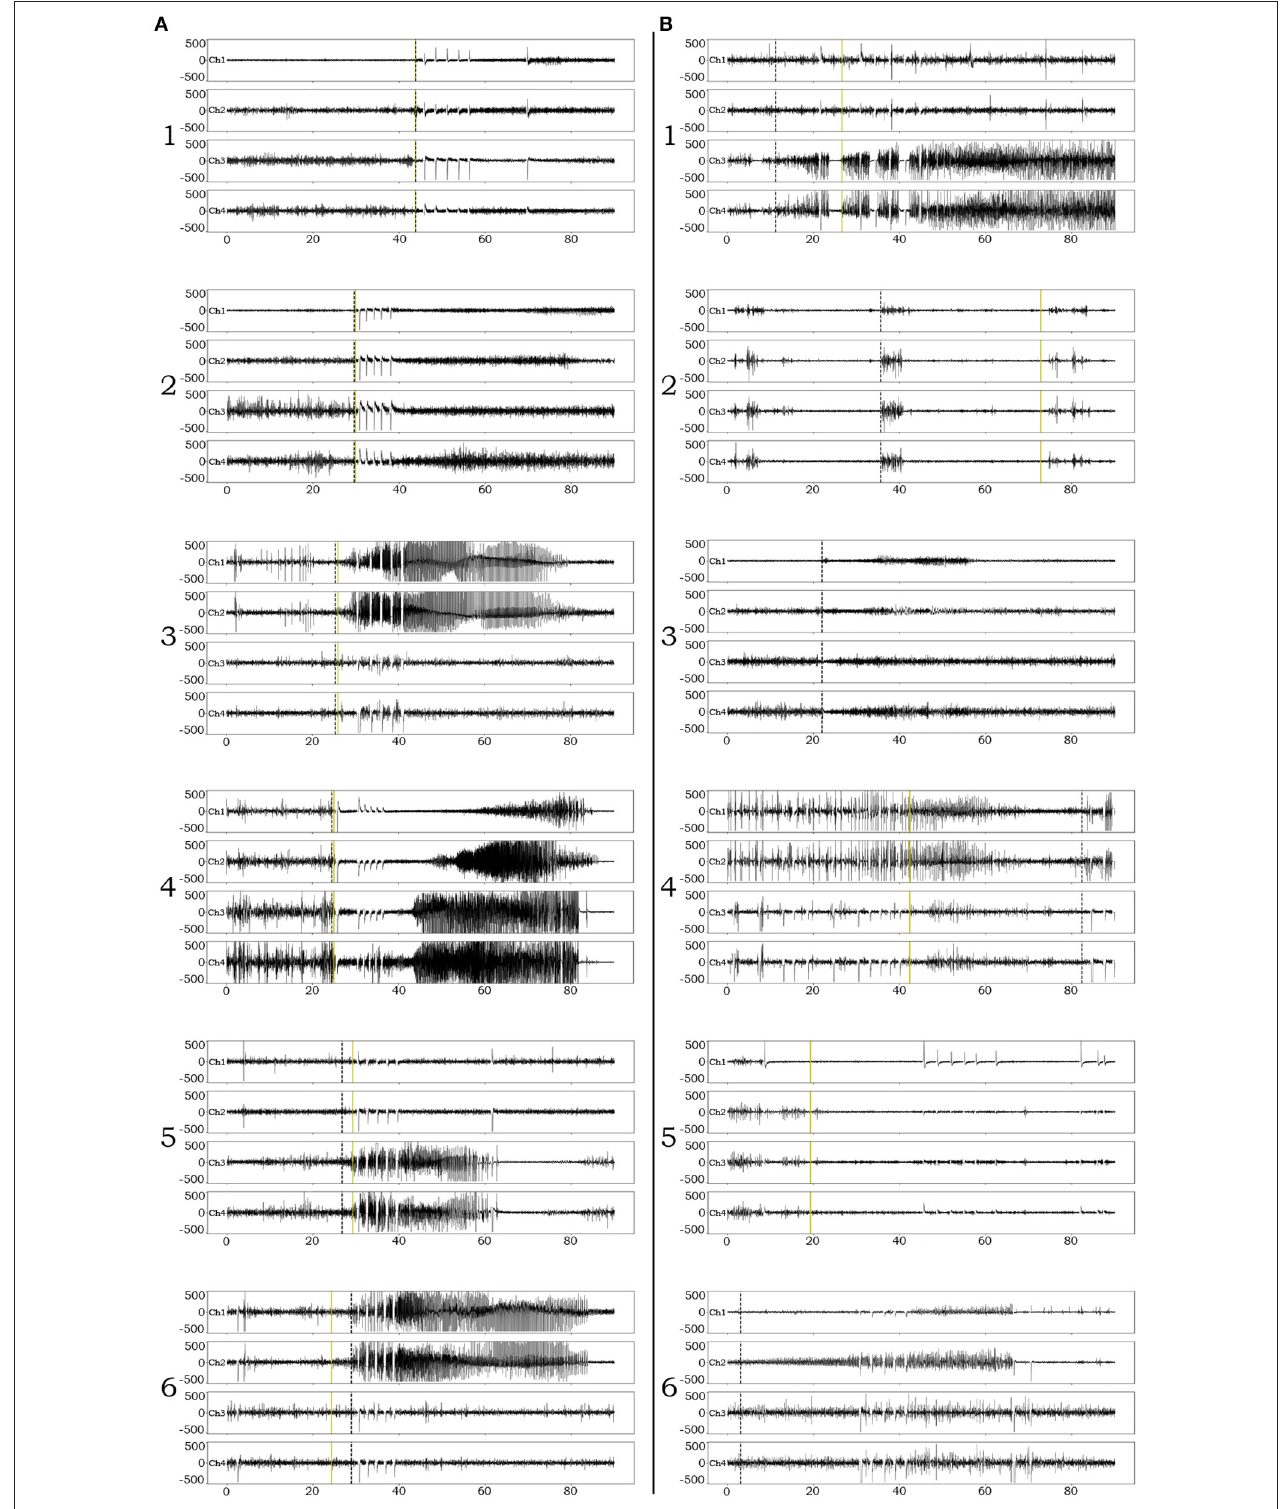
FIGURE 3 | Examples of iEEG ictal pattern detection by the deep-learning neural network. Black dotted vertical lines represent the ictal pattern onset marking set by expert neurophysiologists. Green dotted vertical lines represent the CNN’s annotation. (A) Examples of successful identifications of RNS ictal patterns with